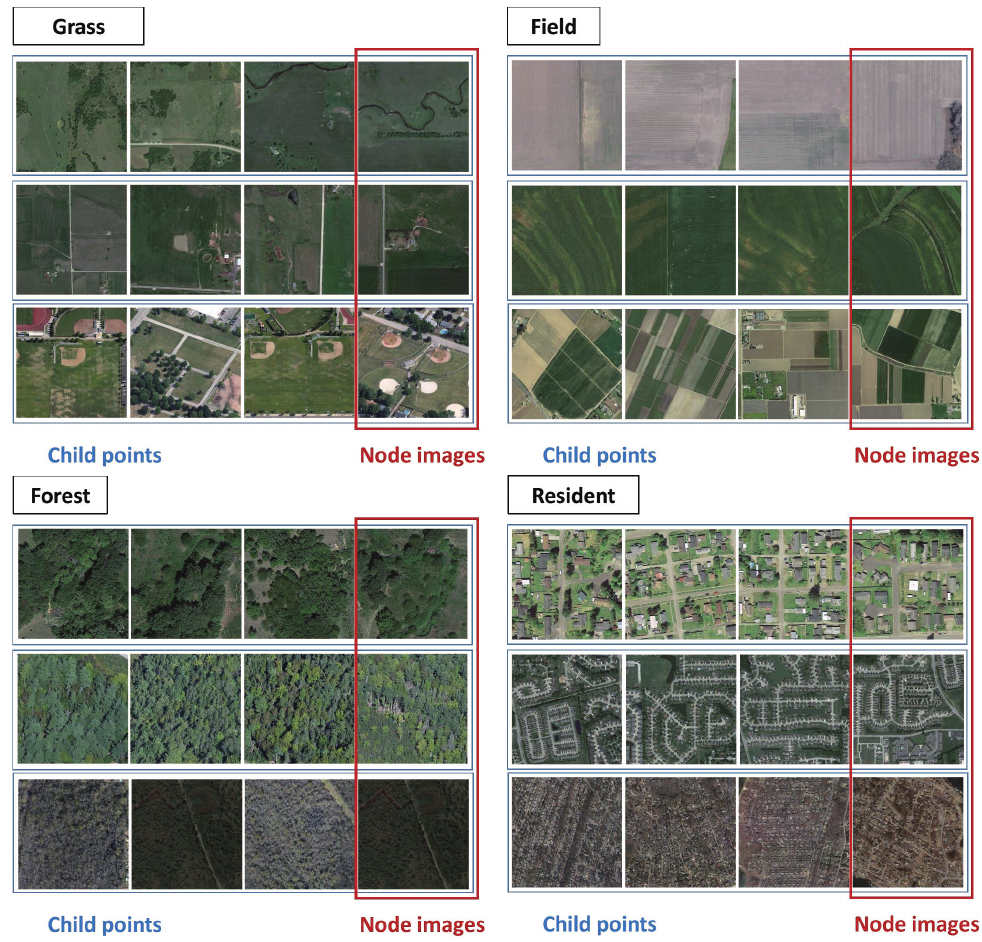
Figure 6. Node images on RSSCN7 dataset.The figure shows four classes in the RSSCN7 dataset: Grass, Field, Forest, and Resident. In each class, three node images and child points connected with them are